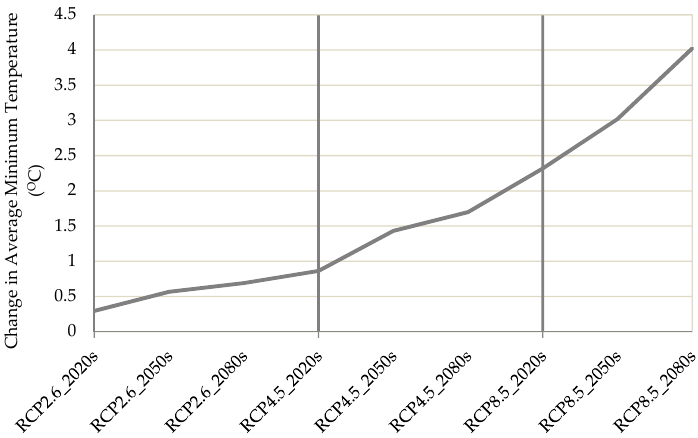
Figure 13. Change in annual average minimum temperature compared to the baseline period (1996– 1990).